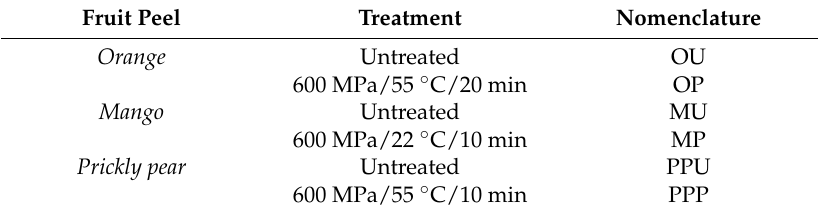
Table 3. Samples nomenclature and their processing conditions. Fruit Peel